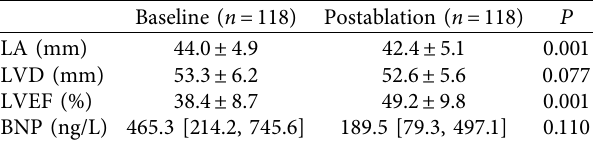
Table 3: Baseline vs.